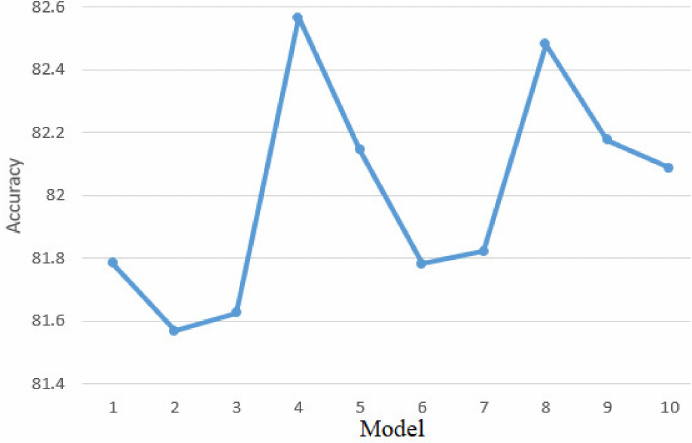
Figure 14. Ten-fold cross-validation